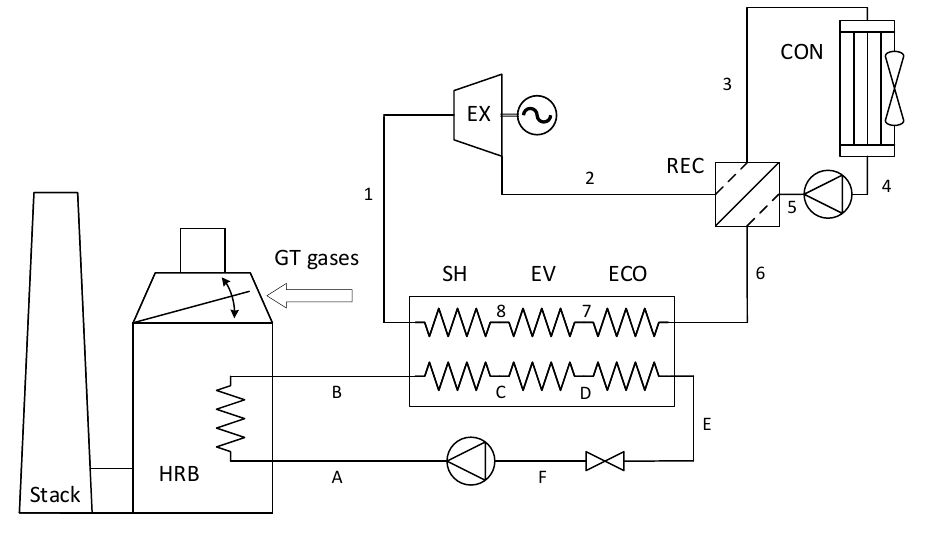
Figure 2. Organic Rankine Cycle (ORC) power plant layout. Points 1–8: organic fluid cycle, points A–F: diathermic oil